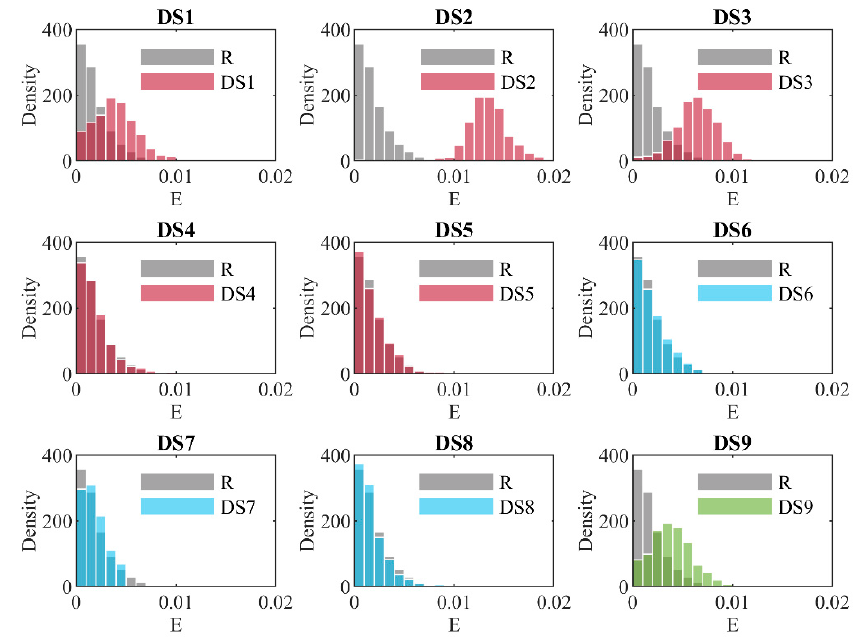
Figure 5. Histogram plots of the instantaneous values of the interpolation error E at sensor 7 for several damage states. Grey bars indicate the reference scenario. Red bars indicate single damage scenarios, blue bars double damages, and green bars triple damage.